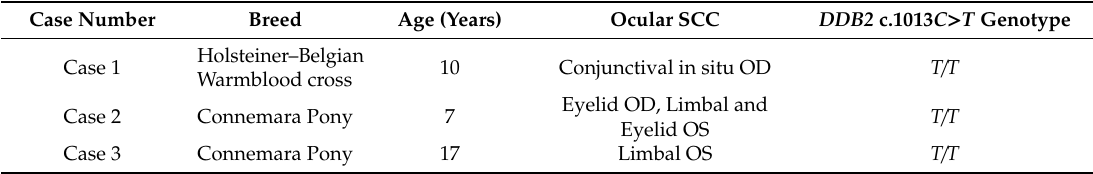
Table 2. DDB2 c.1013 C > T genotype results determined for the three SCC cases under investigation.